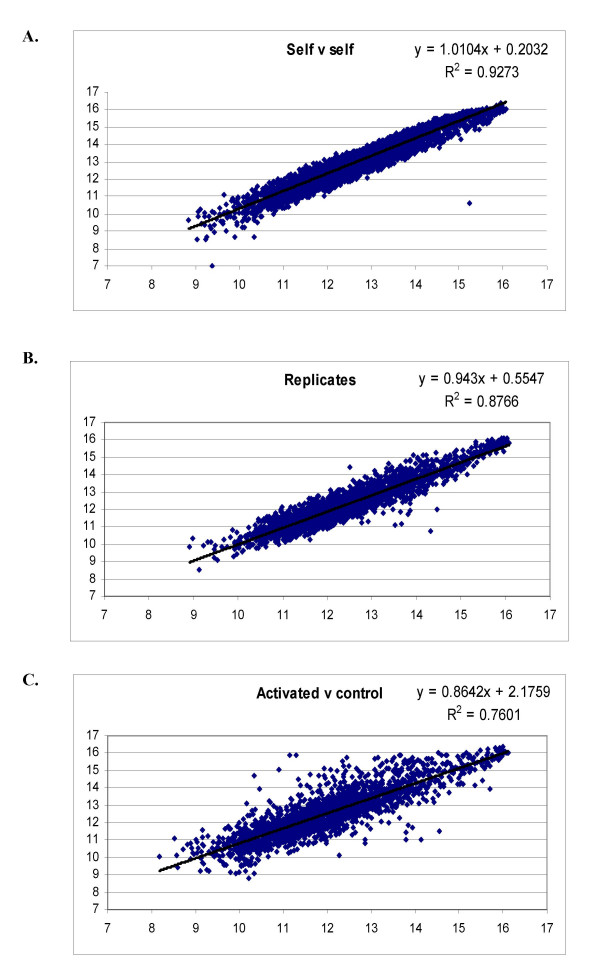
Scatter plots showing the variance between A). self/self hybridisation B). two biological replicates and C). a control sample compared with an activated sample. Very little spread is seen with the self/self hybridisation and between the two replicates, as would be expected. However, differences in gene expression can be seen between the activated and control samples.